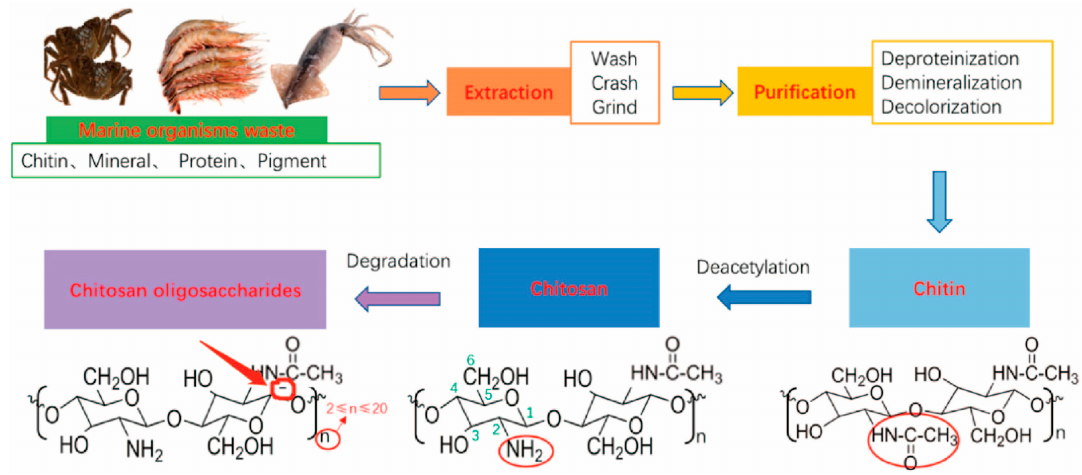
Figure 1. Overview of production and structure of